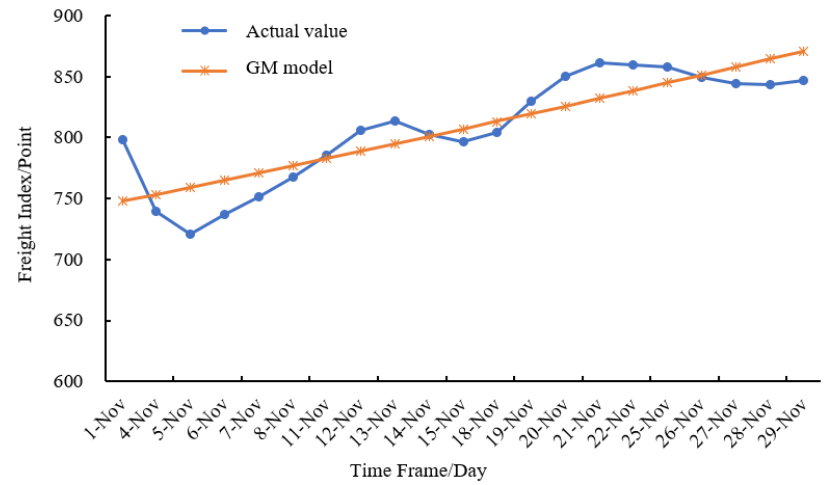
Figure 5. Comparison between forecasting result of GM model and real value.